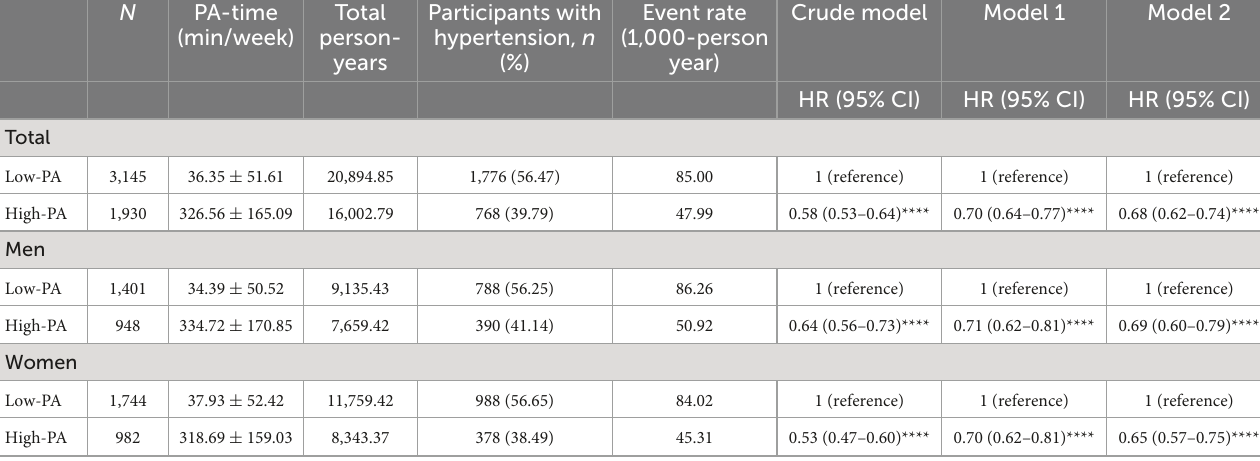
TABLE 2 Leisure-time physical activity (PA) level- and sex-stratified hazard ratios for incident hypertension. N